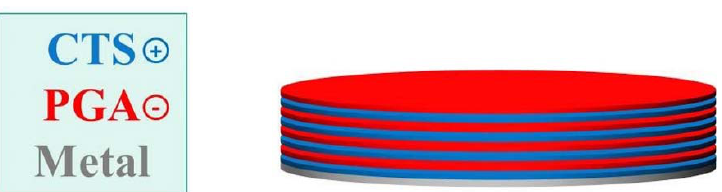
Figure 1. The illustration of chitosan/poly-glutamic acid polyelectrolyte (C/PGA) multilayers.